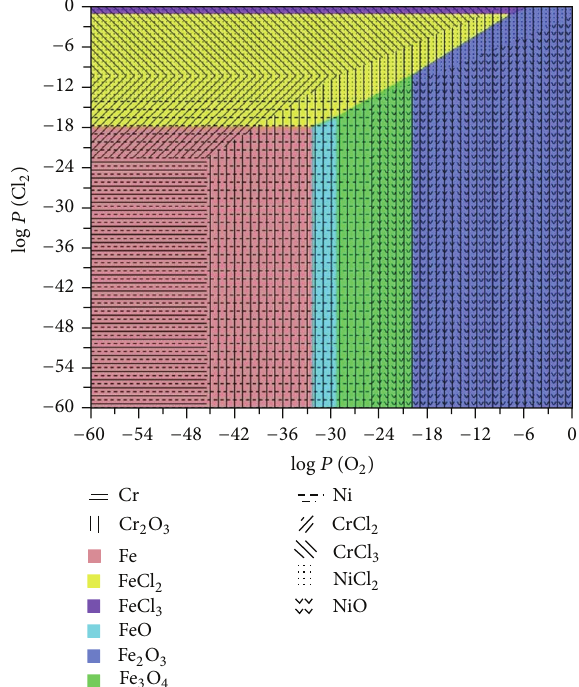
Figure 13: Thermodynamic stability diagrams for Fe-Cr-Ni-Cl-O at 450 ∘